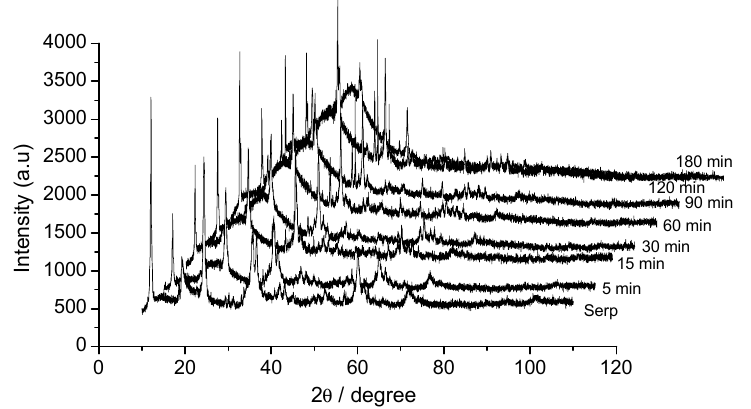
Figure 5. XRD diffractograms of SERP and DW as a function of reaction time.